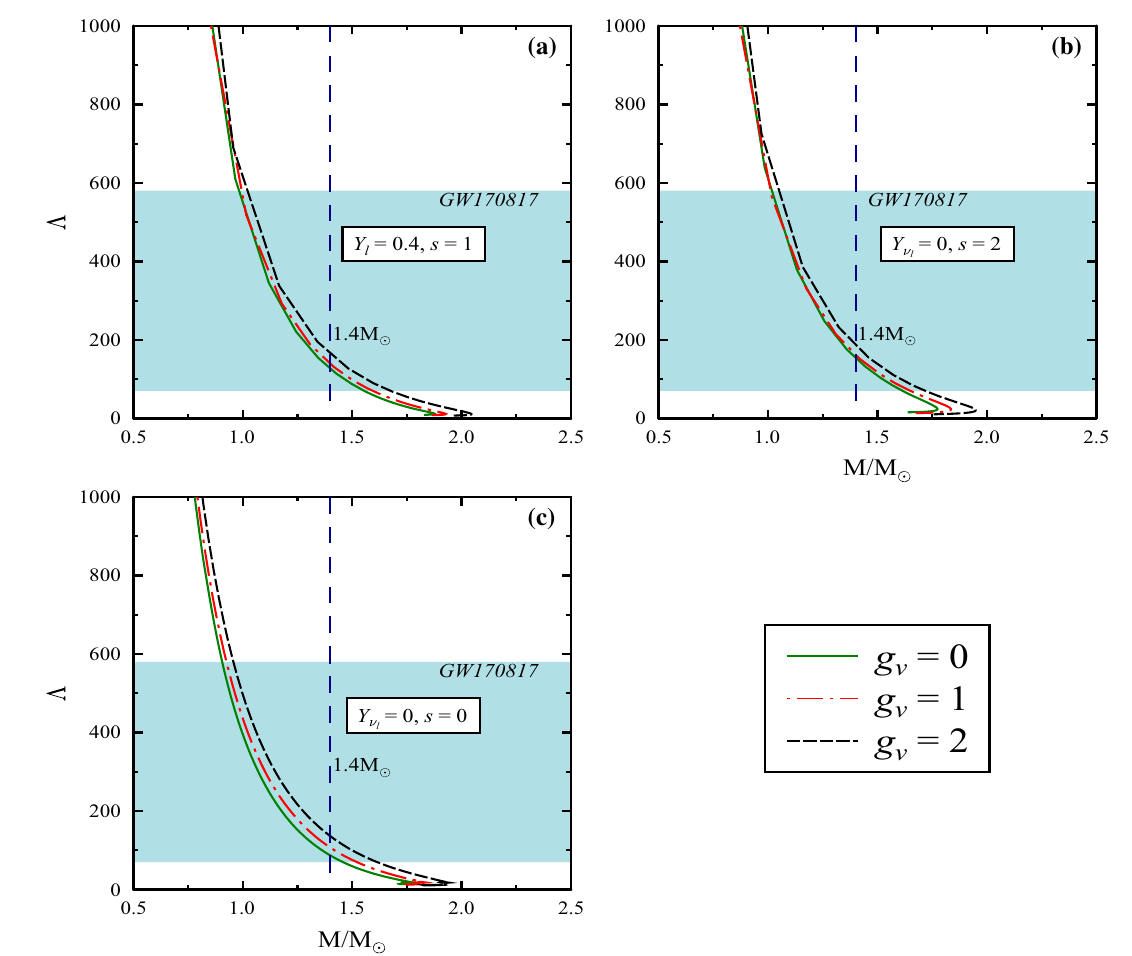
Fig. 10 Relation between tidal deformability and the mass of SQS for different moments of the star evolution at g v = 0, 1 and